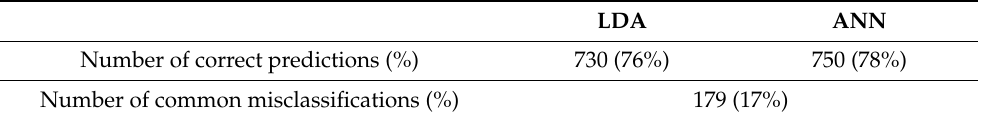
Table 5. Number of correct classifications and misclassifications of the 962 not-B molecules predicted by LDA and ANN. In brackets are reported percentages over the 962 B